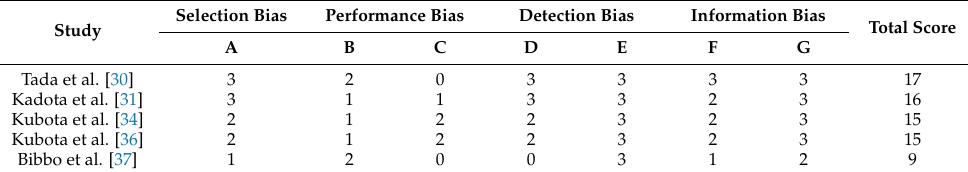
Table 2. Risk of bias assessment for observational studies (NOS adapted